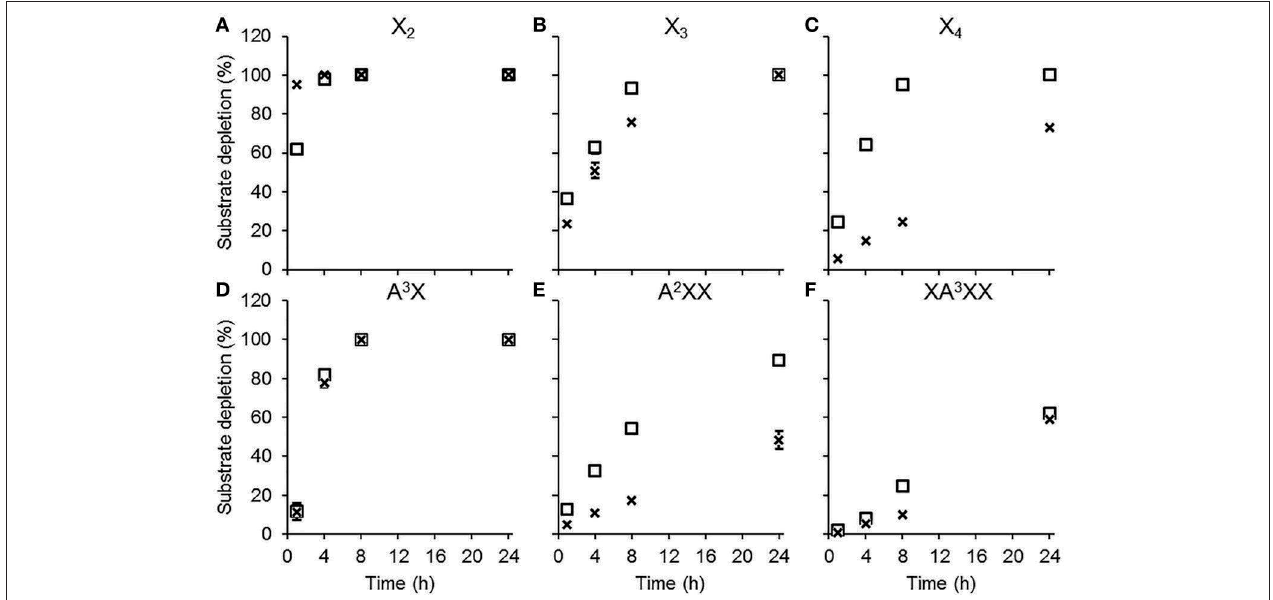
FIGURE 2 | Substrate depletion by AbPDH1 (square) and AmPDH1 (cross) followed by HPAEC-PAD. Substrates: (A) xylobiose, X 2 , (B) xylotriose, X 3 , (C) xylotetraose, X 4 , (D) 3 2 - α -L-arabinofuranosyl-xylobiose A 3 X, (E) 2 3 - α -L-arabinofuranosyl-xylotriose, A 2 XX, and (F) 3 3 - α -L-arabinofuranosyl-xylotetraose XA 3 XX. Depletion of 5mM substrate using 0.2 U/ml PDHs, 1mM BQ and 0.2 U/ml laccase was compared to the control reaction containing all reaction components except PDH. Error bars show the data range of duplicate reactions. Error bars are not visible when the data range fits inside the drawn data